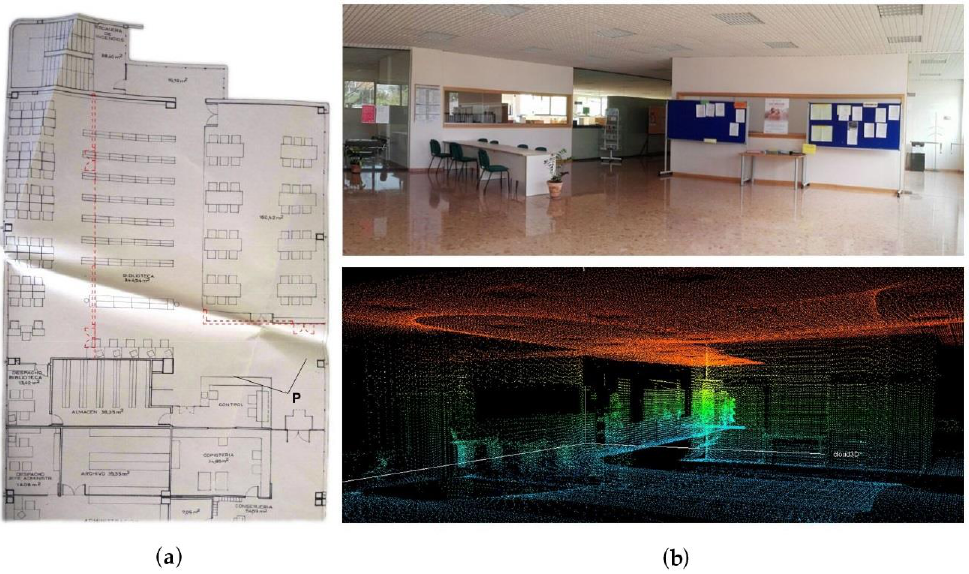
Figure 8. Deviations revealed after the inspection: ( a ) plan view; and ( b ) the as-built environment.